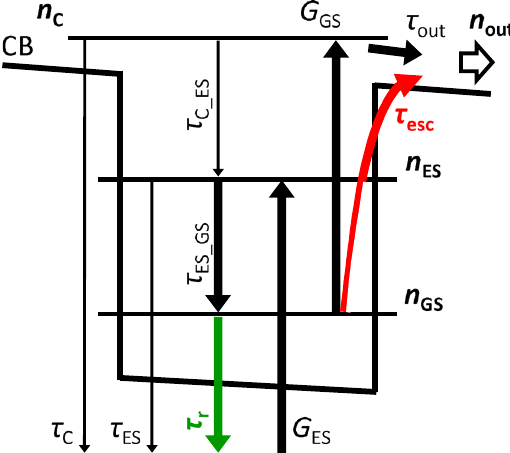
Figure 4. Schematic diagram of the simulation model used in this work. GS and ES of QDSLs were taken into account in the calculations. Extracted current density n out was calculated as a function of the internal electric field and the interband excitation